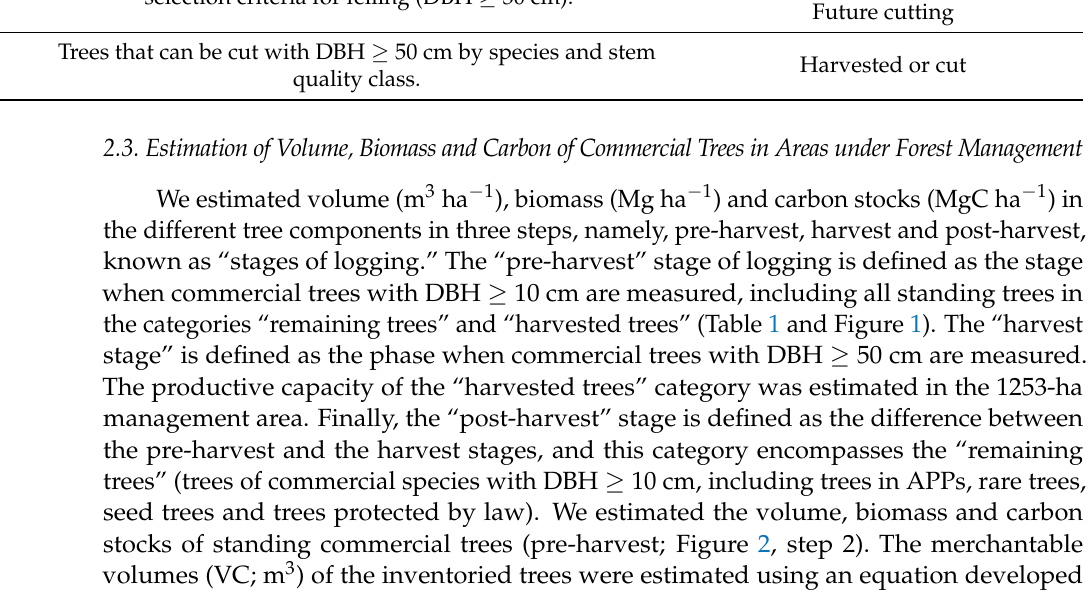
Remaining trees